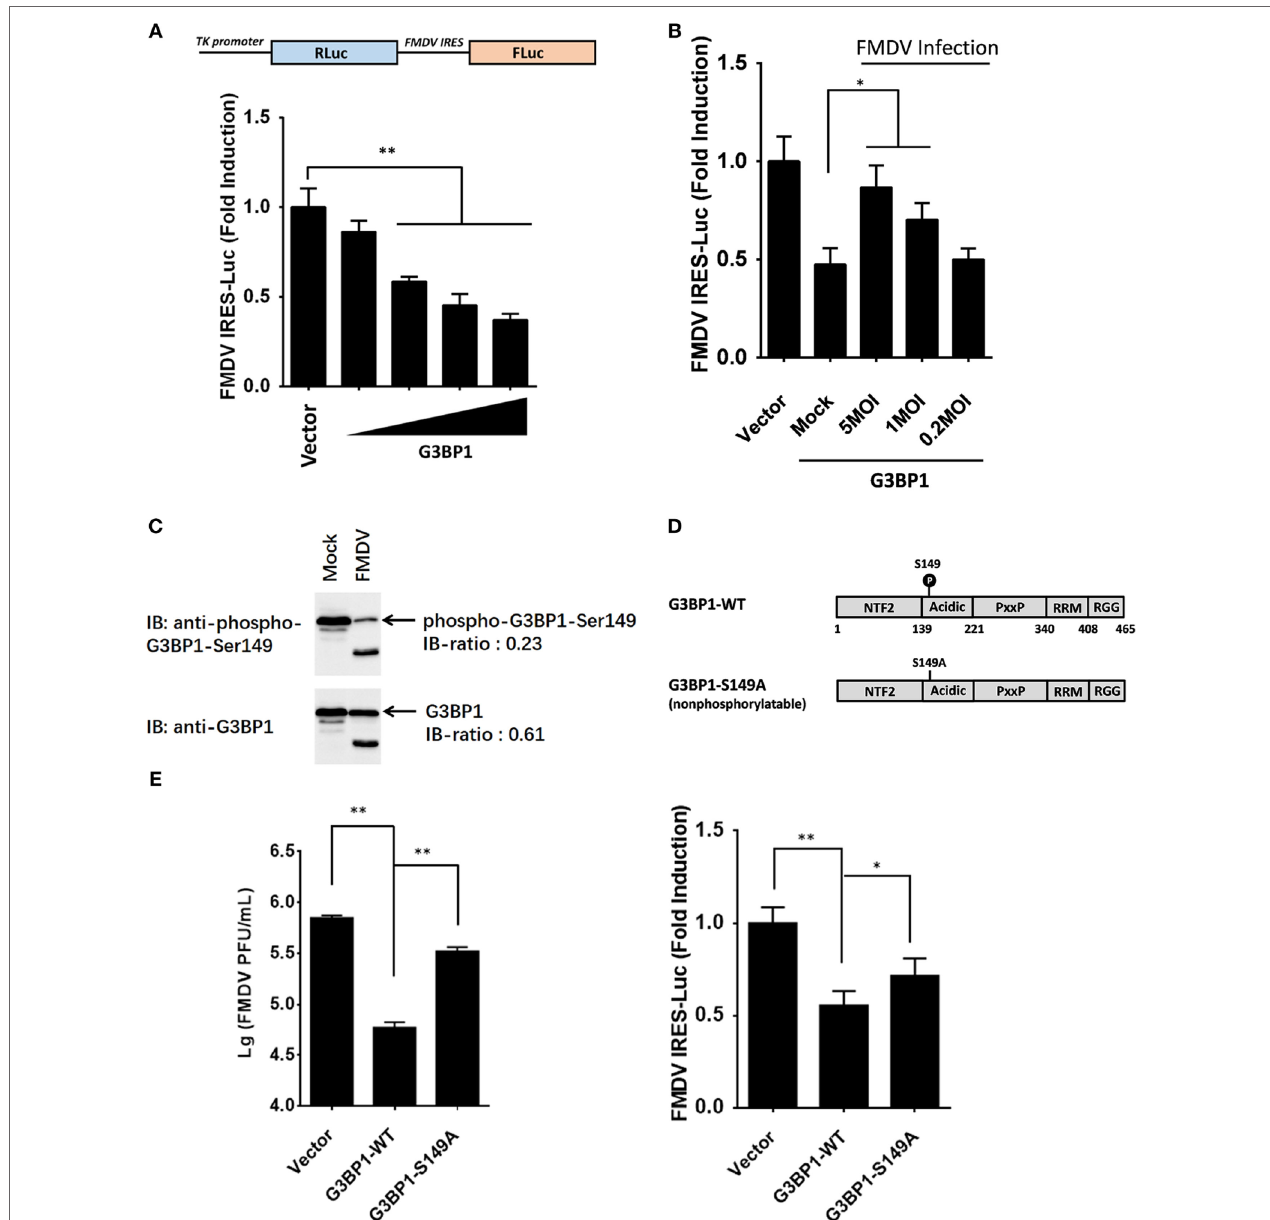
FigUre 4 | Dephosphorylation of G3BP1 is involved in foot-and-mouth disease virus (FMDV) internal ribosome entry site (IRES) activity. (a) Schematic representation of the construct TK-Renilla luciferase(Rluc)-IRES-Firefly luciferase(Fluc). IBRS-2 cells were transfected with TK-Rluc-IRES-Fluc along with increasing quantities (0, 0.125, 0.25, or 0.5 µg) of plasmid encoding porcine G3BP1, using Lipofectamine 2000. Luciferase assays were performed 36 h after transfection. (B) IBRS-2 cells were transfected with TK-Rluc-IRES-Fluc along with porcine G3BP1 expression plasmid or an empty vector (0.5 µg). 30 h after initial transfection, cells were infected with FMDV at different MOIs. Luciferase assays were performed 6 h after FMDV infection. (c) IBRS-2 cells were infected with FMDV (MOI = 5). After 6 h post-infection, total cell lysates were prepared and analyzed with western blotting with rabbit anti-G3BP1 and rabbit anti-phospho-G3BP1-Ser149 antibodies. Immunoblotting ratios (infection/control) were quantified by ImageJ. (D) Schematic representation of wild-type porcine G3BP1 and its derivatives. The domains of porcine G3BP1 were annotated analogously to those of human G3BP1. IBRS-2 cells were transfected with Flag-tagged wild-type G3BP1 or its mutants as indicated, along with TK-Rluc-IRES-Fluc. Luciferase assays were performed at 36 h after the transfection. (e) IBRS-2 cells were transfected with the designated flag-tagged porcine G3BP1 expression plasmids or its mutants or an empty vector, and, 30 h later, the cells were infected with FMDV (MOI = 5). 6 h after FMDV infection, virus plaque was performed to analyze for virus